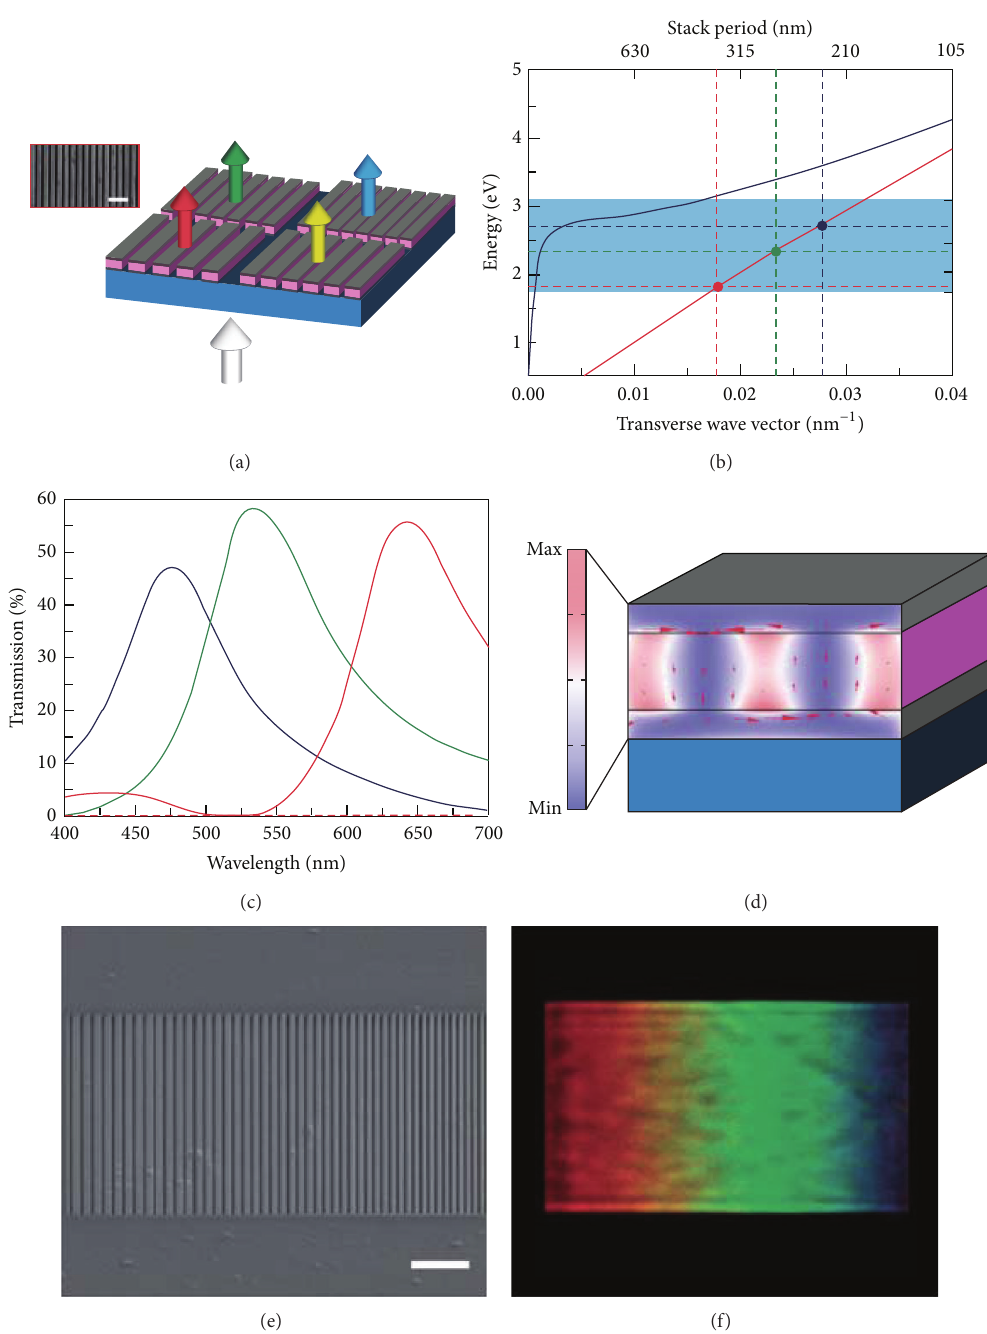
Figure 6: (a) Schematic diagram of the proposed plasmonic nanoresonators. Inset is the scanning electron microscopy (SEM) image of the fabricated device. Scale bar, 1 𝜇 m. (b) Plasmon dispersions in MIM stack array. The shaded region indicates the visible range. (c) Simulated transmission spectra for the RGB filters. The solid and dash curves correspond to TM and TE illuminations, respectively. (d) Cross section of the time-average magnetic field intensity and electric displacement distribution (red arrow) inside the MIM stack at a wavelength of 650 nm with 360 nm stack period. (e) SEM image of the fabricated 1D plasmonic spectroscope with gradually changing periods from 400 to 200 nm (from left to right). Scale bar, 2 𝜇 m. (f) Optical microscopy image of the plasmonic spectroscope illuminated with white light. Figures are reproduced from